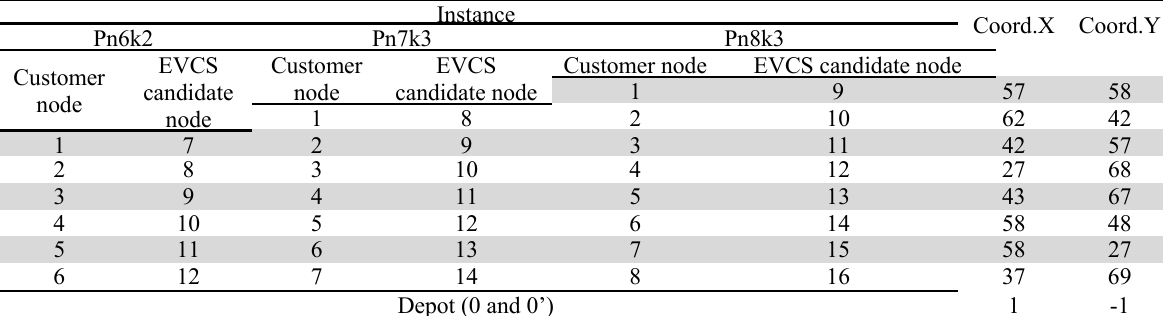
Small-size transportation network